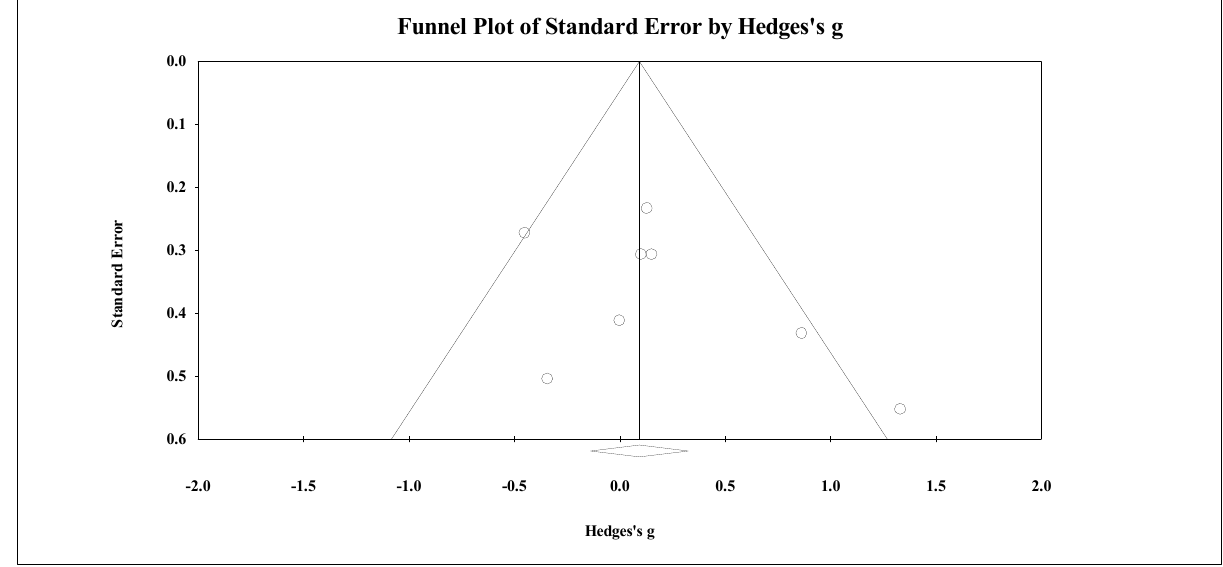
Figure 3. Funnel plot for changes in total body bone mineral density in untrained adults after a training program based on soccer small-sided games compared to a passive control condition. White circles: observed studies.